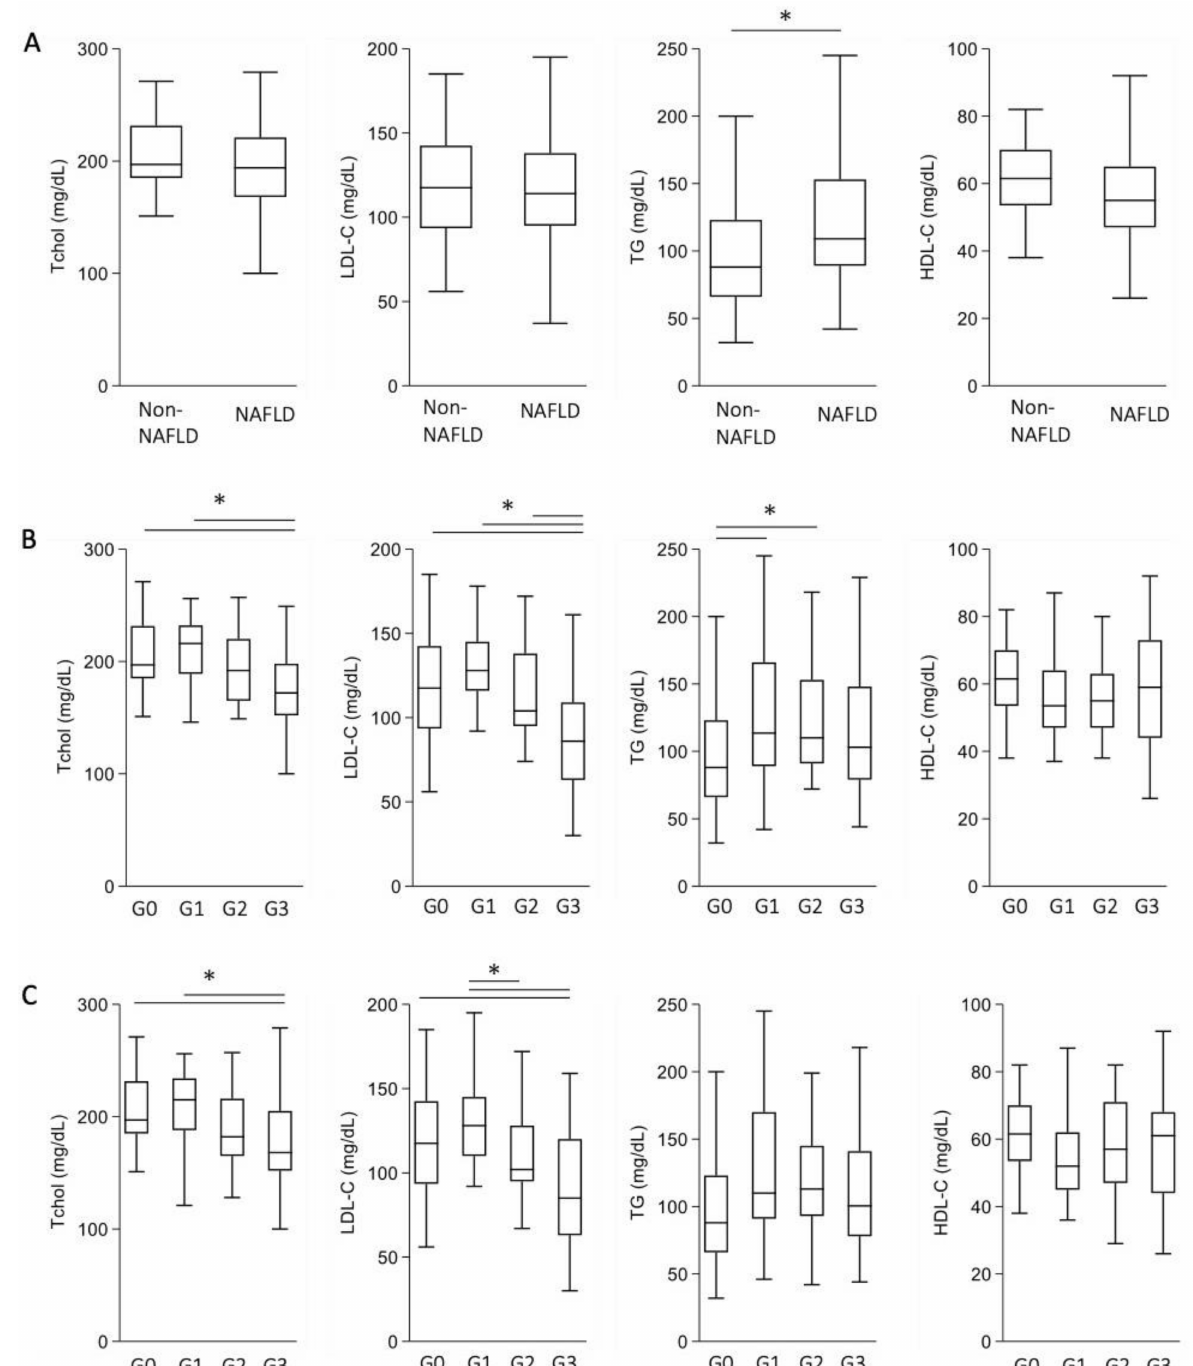
Figure 1. The levels of total cholesterol, low-density lipoprotein (LDL) cholesterol, triglyceride, and high-density lipoprotein (HDL) cholesterol in non-NAFLD subjects and patients with NAFLD. ( A ) Non-NAFLD ( n = 32) versus NAFLD ( n = 106). ( B ). Lipid levels after stratification by the FIB-4 index. G0, Non-NAFLD ( n = 32); G1, group 1 ( n = 38); G2, group 2 ( n = 35); G3, group 3 ( n = 33). ( C ) Lipid levels after stratification by the NFS. G0, Non-NAFLD ( n = 32); G1, group 1 ( n = 47); G2, group 2 ( n = 33); G3, group 3 ( n = 26). * p <